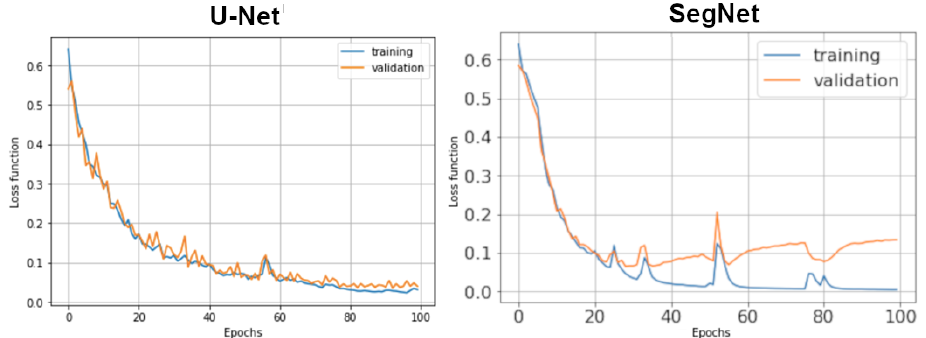
Figure 10. Trend curve of loss function.